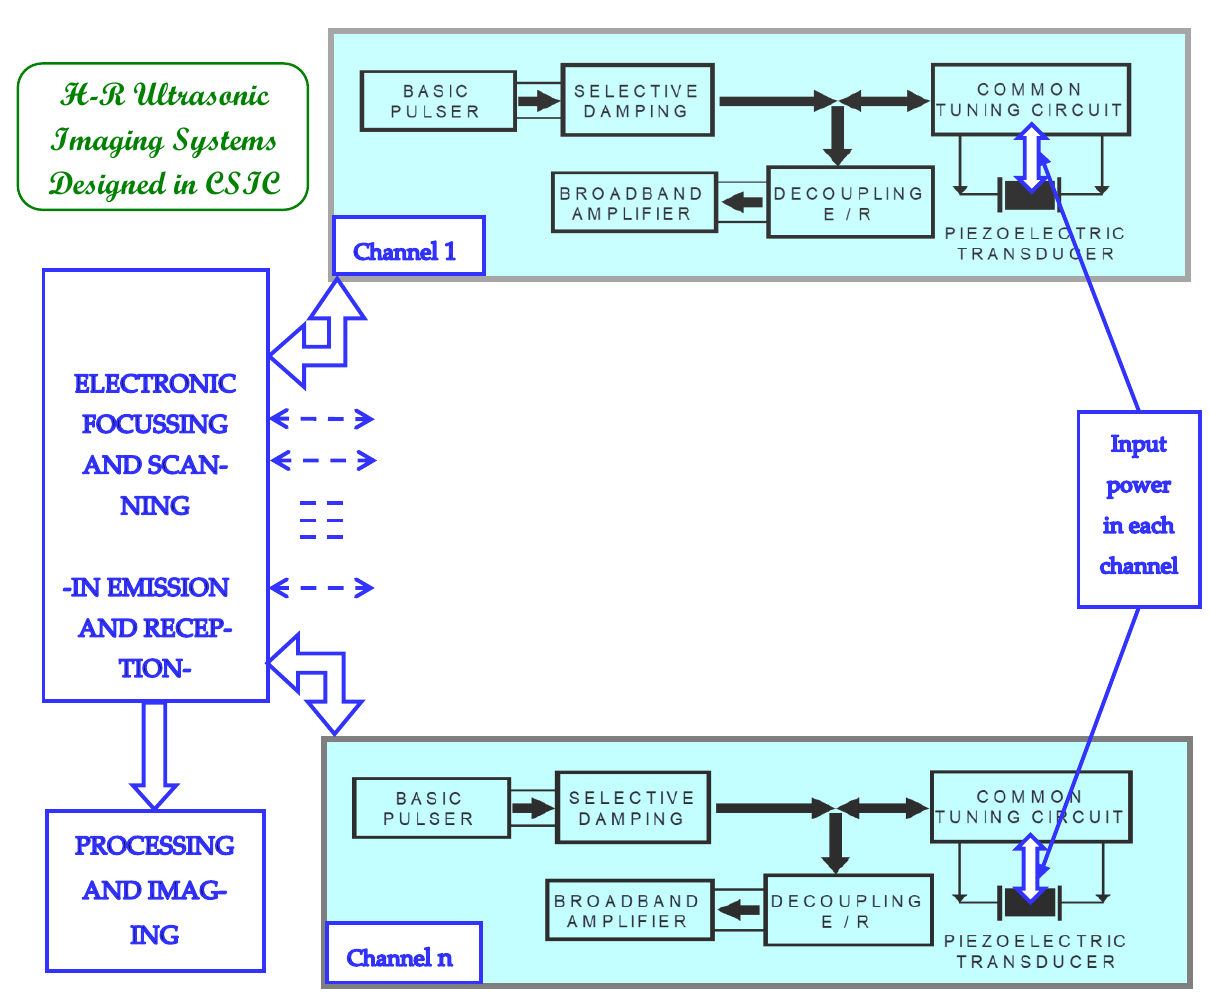
Figure 1. Structure of our HR ultrasonic imaging systems designed in CSIC, which contain a number of controlled E/R ultrasonic channels (from 16 to 128). It usually includes n analogic transceivers digitally controlled by complex systems for electronic focusing and HV scanning in emission and reception stages, and a unit for processing and displaying of the received signals and images.